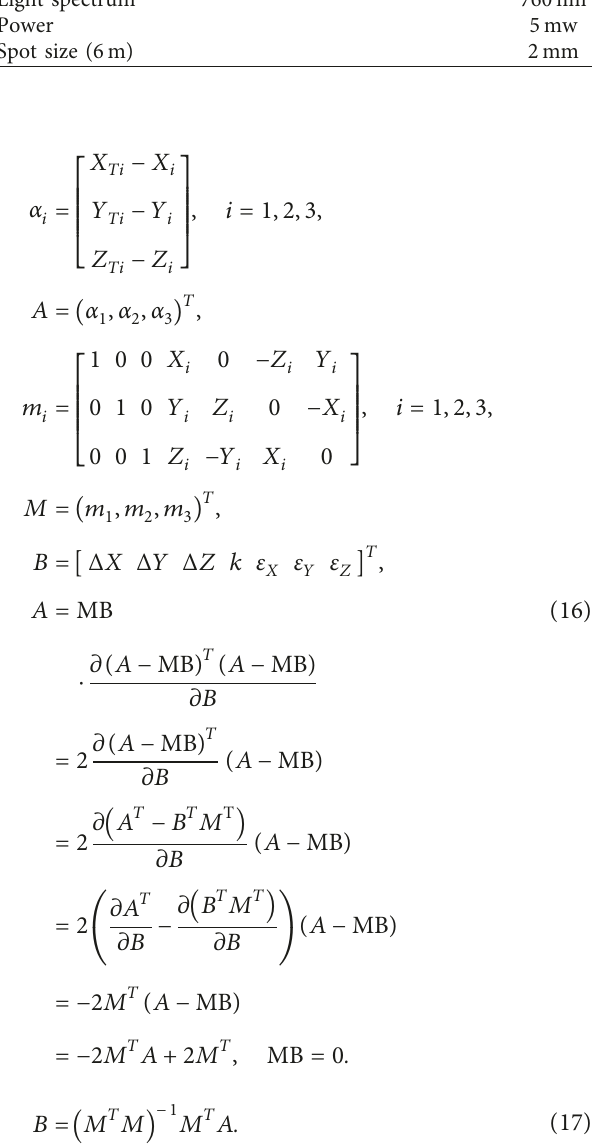
Figure 10: Laser emission system.